Question: Briefly state, in one sentence, what is plotted here.
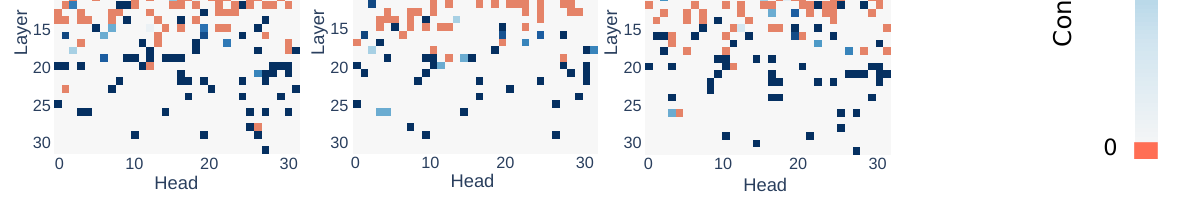
Answer: When does the LLM start following the context? Distribution of context-abidance score cj,k of each head (darker blue shade signifies higher cj,k) with layer (j) on y-axis and head index (k) on x- axis. Attention heads in red denote those with zero context-abidance. We show the distributions for all the subtask indices 0-9 (left to right, top to bottom). Typically, context abidance is task-agnostic and emerges after the 16th decoder block.